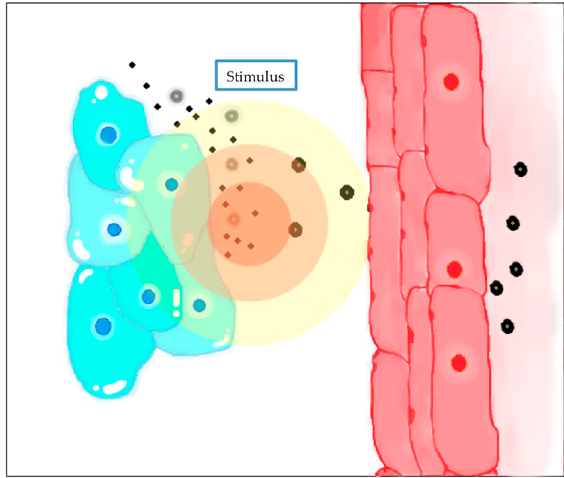
Figure 5. The exposure to a stimulus triggers congregated nanoparticles drug release.